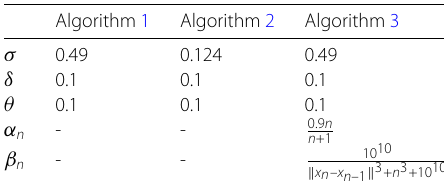
Table 2 Chosen parameters of each algorithm